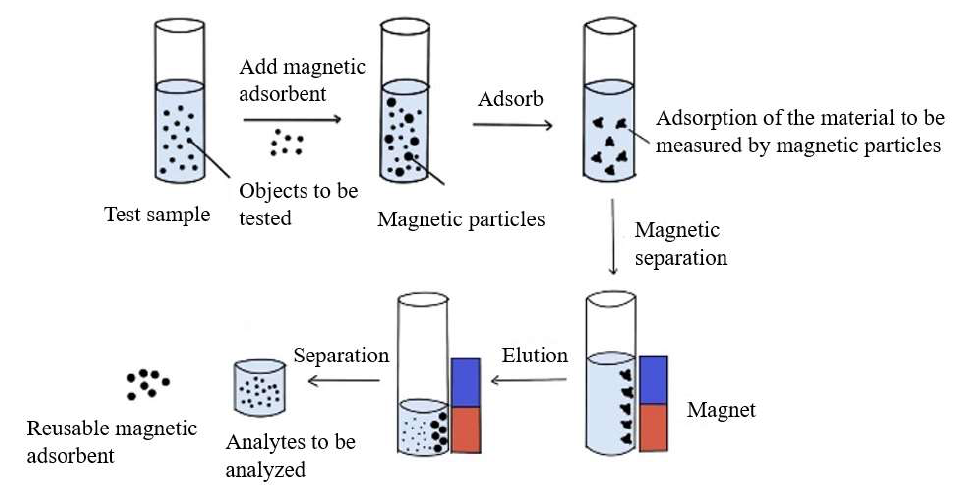
Scheme 1. Flow chart of sample pretreatment magnetic solid phase extraction